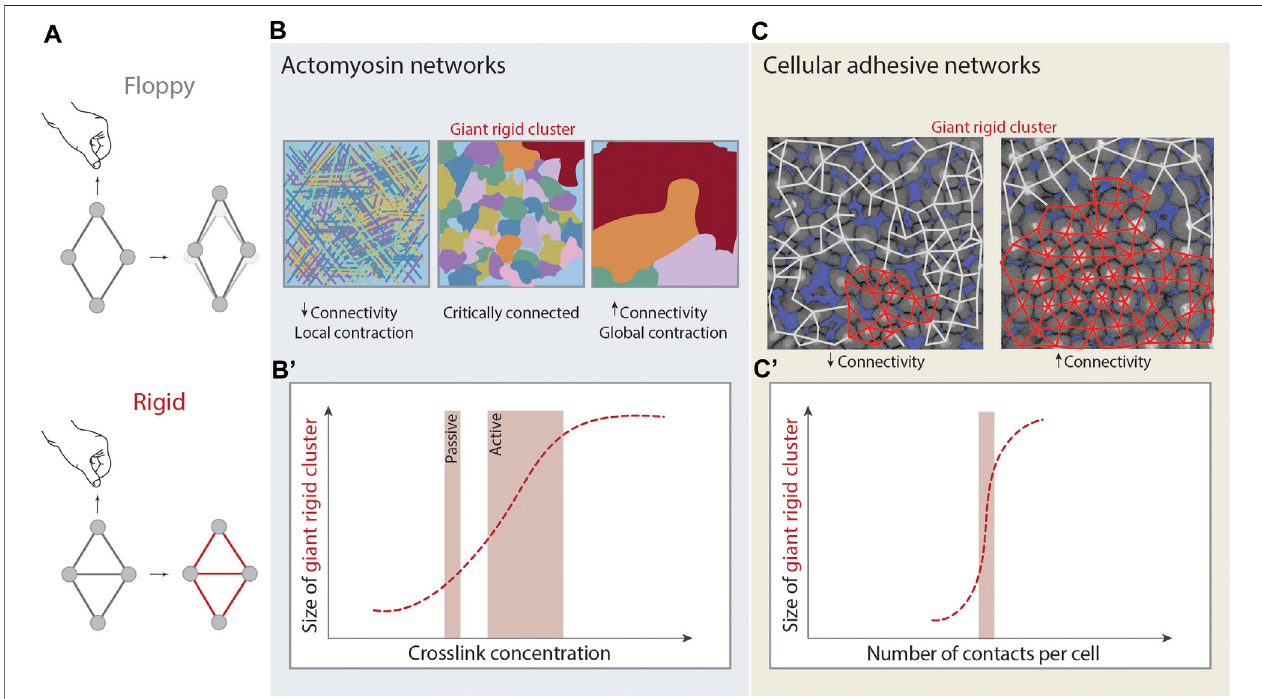
FIGURE 3 | Rigidity percolation in living systems. (A) Schematic illustration of rigidity. A rhombus cluster of four nodes and four links deforms in the presence of a deformation force. Just by the addition of one link that absorbs the remaining degrees of freedom of the central nodes, under the same deformation force it does not deform and it is considered rigid. (B,B ’ ) Rigidity percolation transition in actomyosin crosslinked networks. (B) At low connectivity (left) or low crosslinker concentration thenetworkismostlydisconnectedanddisplayslocalcontractions.Atintermediateconnectivity(middle)andintermediate crosslinkerconcentrationthenetworkis critically connected. At higher connectivity (right) and high crosslinker concentration the network is fully connected, the Giant Rigid Cluster (GRC, red) emerges and the network displays global contractions and signs of fracture. (B ’ ) Plot of the size of the GRC as a function of crosslinker concentration and thus average connectivity. Depending on the absence or presence of contractility the system can be considered as passive or active respectively, and this changes the transition point. Figure adapted from [43]. (C,C ’ ) Rigidity percolation transition in cellular networks - tissues - of the zebra fi sh embryonic blastoderm. (C) At low average connectivity ( ∼ 3.5 contacts per cell) the GRC (red) is small and the blastoderm is fl uidized whereas at higher connectivity ( > 4 contacts per cell) the GRC is big, occupies almost the whole network and the tissue displays experimentally high viscosity. (C ’ ) Plot of the size of the GRC as a function of cell connectivity. Note that the GRC is emerging sharply at the critical point of connectivity (2/3 of maximum potential connectivity). Figure adapted from